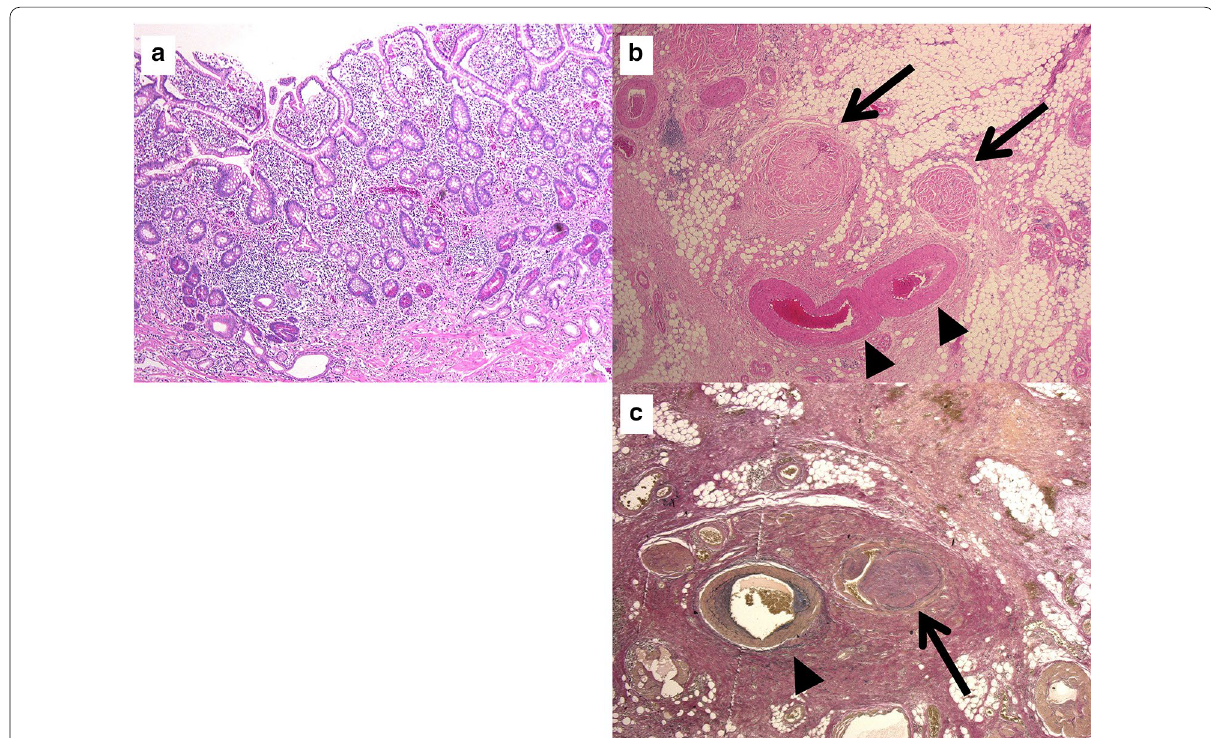
Fig. 5 Microscopic findings: Active inflammation and fibrotic change are observed ( a Hematoxylin and eosin staining, 40). Thickening of the × venous wall is observed (black arrow), and the veins seem more prominent than their accompanying arteries (arrowhead) and have a markedly narrowed lumen ( b Hematoxylin and eosin staining, 200). The elastin staining allows hyperplastic veins (arrow) to be distinguished from the × normal arteries (arrowhead), which show a bilayer structure (internal and external elastic lamina) ( c Elastica van Gieson